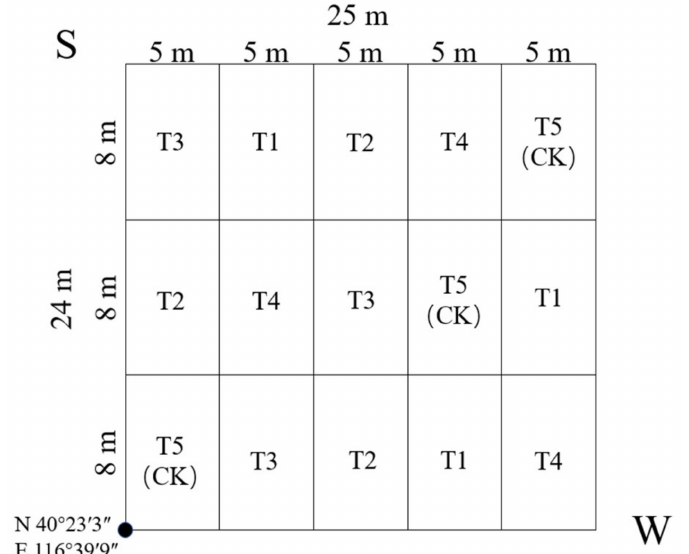
Figure 2. Sample plots showing setting and fertilization type distribution. T1: adjustment of C/N and C/P + 0.2% priming; T2: adjustment of C/N and C/P + 0.2% common compost; T3: adjustment of C/N and C/P; T4: raw material grinding of thinning shreds; T5: no fertilization. The volume of fertilizer applied was 900 g · m − 2